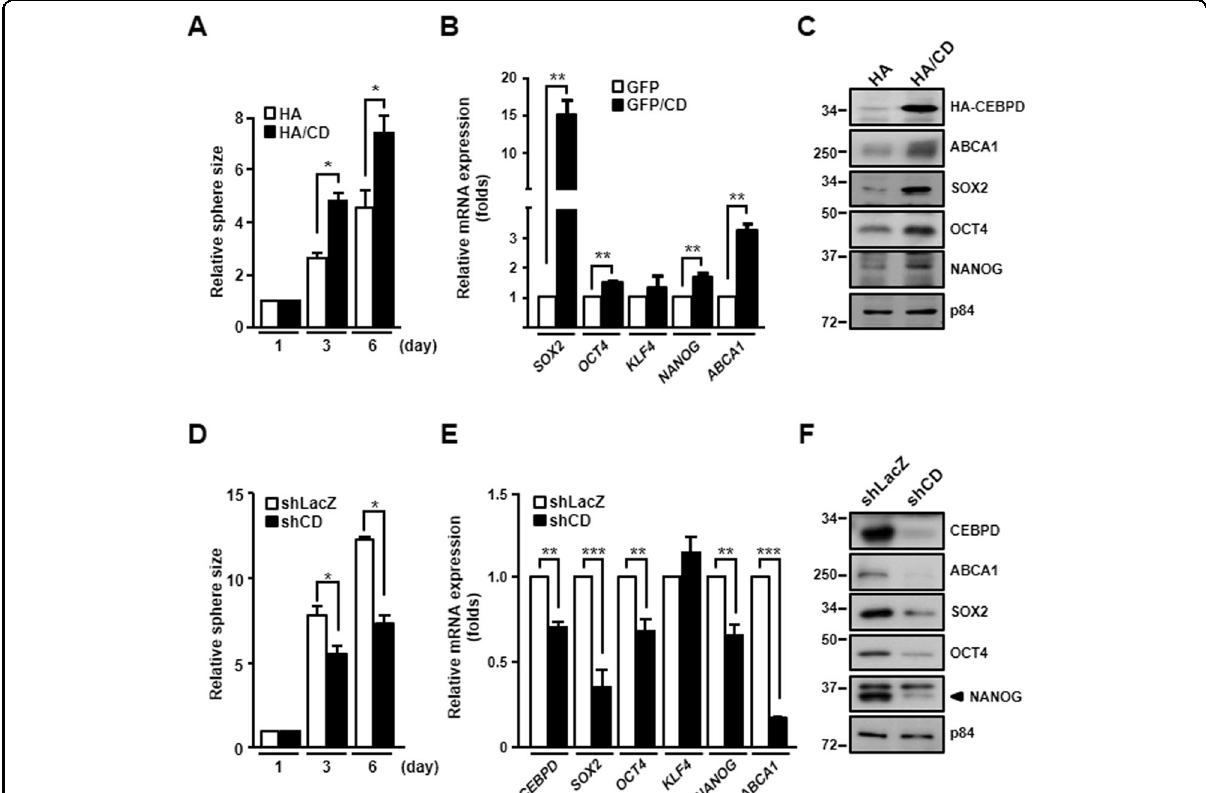
Fig. 3 CEBPD promotes spheroid formation by regulating stemness-related factors and ABCA1 expression. A U87MG cells transiently expressing HA or HA-CEBPD were cultured in stem cell medium to form spheroids for 3 days and 6 days. B U87MG cells transiently expressing GFP or GFP-CEBPD were cultured in stem cell medium to form spheroids for 6 days. Total RNA were harvested and examined by RT-qPCR to detect the expression of SOX2 , OCT4 , NANOG , KLF4 , and ABCA1 . C Total protein lysates were harvested from ( A ) and examined by western blot to detect the expression of SOX2, OCT4, NANOG, KLF4, and ABCA1. D LacZ-knockdown or CEBPD-knockdown U87MG cells were cultured in stem cell medium to form spheroids for 3 days and 6 days. E Total RNA and F total protein lysates were harvested from shLacZ-U87MG or shCD-U87MG spheroid cells and examined by RT-qPCR and western blot to detect the transcription and expression of SOX2, OCT4, NANOG, KLF4, and ABCA1. The summary data are presented as the mean ± SEM; the numbers in the bars represent the sample sizes; one-way ANOVA and Student ’ s t -test; * p < 0.05, ** p < 0.01, *** p < 0.001. HA: hemagglutinin, HA/CD: HA-tagged CEBPD, GFP: green fl uorescent protein, GFP/CD: GFP-tagged